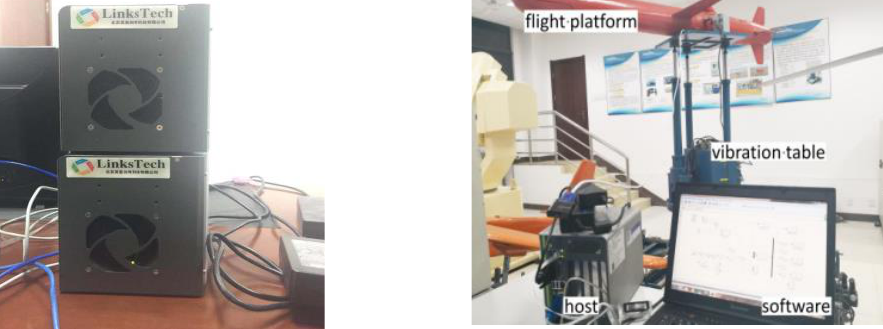
Figure 5. Semi-physical simulation platform.